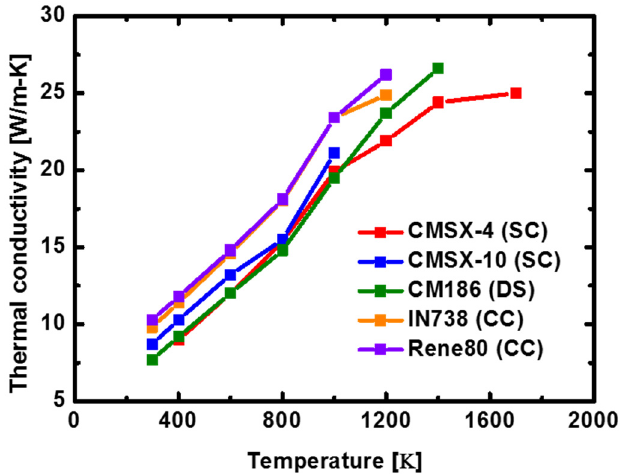
Figure 8. Variation of thermal conductivity of nickel-based superalloys with temperature according to